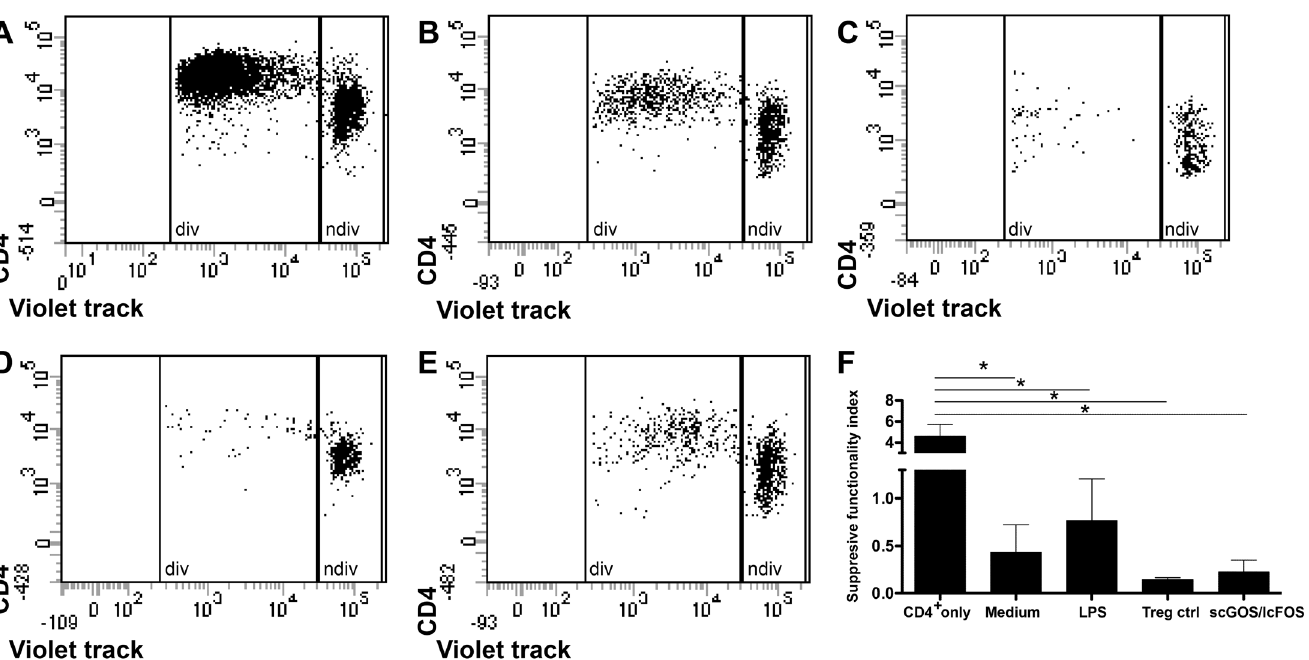
Fig 7. Suppressive capacity of T cells induced by scGOS/lcFOS-treated MoDC. T cells of allogeneic stimulation assays (ASA) were harvested on day seven and co-incubated with freshly isolated, violet-labeled responder CD4 + T cells a ratio of 1:1 for five days in presence of anti-CD3/28 and rhIL-2. The mix of ASA cells and violet stained responder CD4 + T cells was then stained (after five days of co-incubation) with CD4 APC-Cy7. The dot plots show data from one representative experiment. Proliferation of responder T cells only (A) or in co-incubation with T cells induced by medium- (B), LPS- (C) and scGOS/ lcFOS- (E) stimulated MoDC and Treg control (D) is shown. Results in (F) are presented as mean ± SEM, 4 independent experiments are depicted. Proliferation of violet-positive cells was analyzed by flow cytometry and suppressive functionality index was determined by calculating dividing cells (div)/ non-dividing (ndiv) cells (F). * p < 0.05, Mann Whitney test. ASA = allogeneic stimulation assay, scGOS/lcFOS = short chain galacto-, long chain fructo- oligosaccharides, MoDC = monocyte-derived dendritic cells, div = dividing cells, ndiv = non-dividing cells.